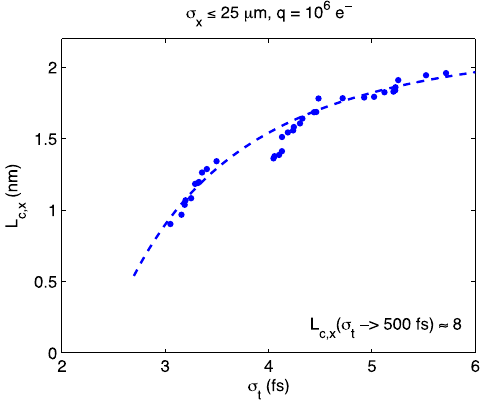
FIG. 5. Optimal beam line element positions for a final beam spot size of σ z ≤ 25 μ